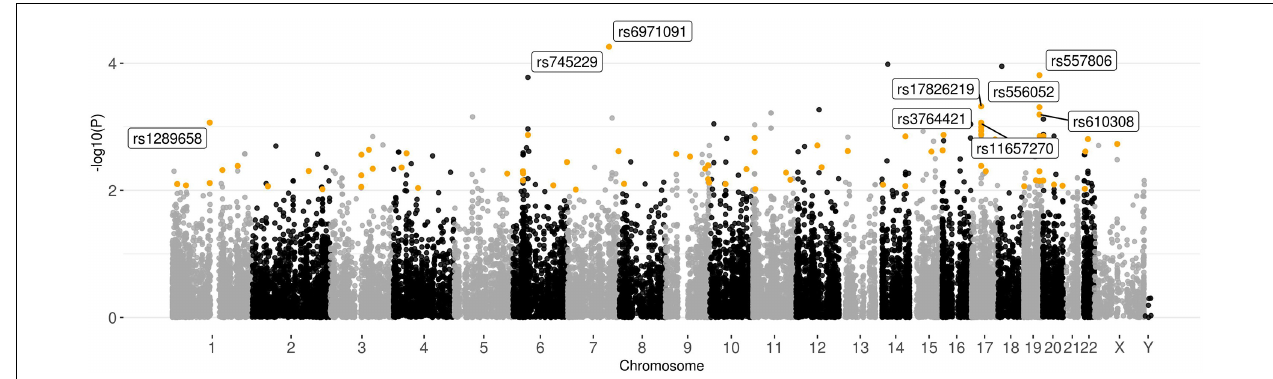
FIGURE 4 | Graphical summary of the results of the association analysis of 157 samples. Plot of –log10( p -values) of the χ 2 test. Polymorphisms with p -value < 10 − 2 and high or moderate impact based on the VEP results located in the genes expressed in the testis ( > 1NX) are highlighted.